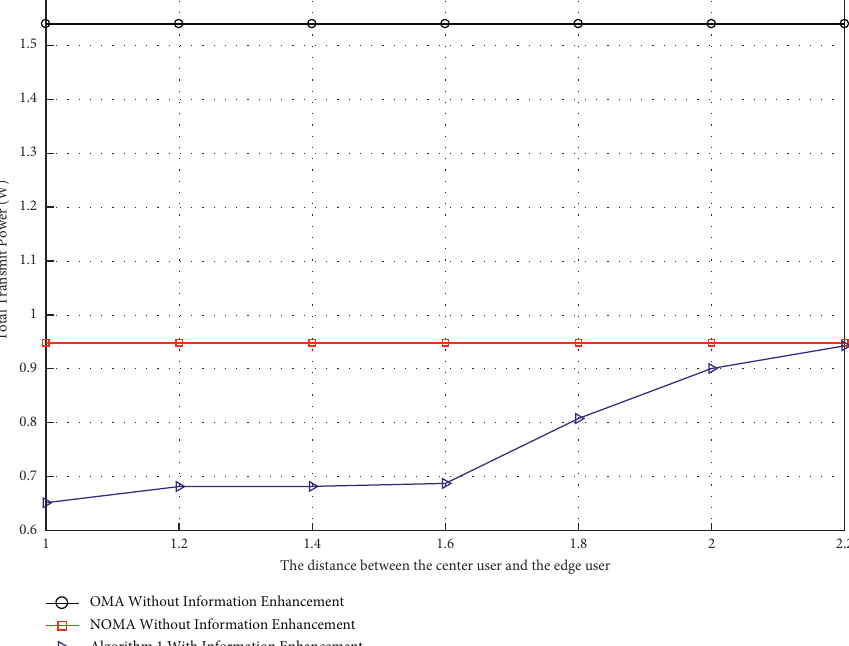
Algorithm 1 OMA Without Information Enhancement Algorithm1 NOMA Without Information Enhancement Algorithm 1 NOMA With Information Enhancement